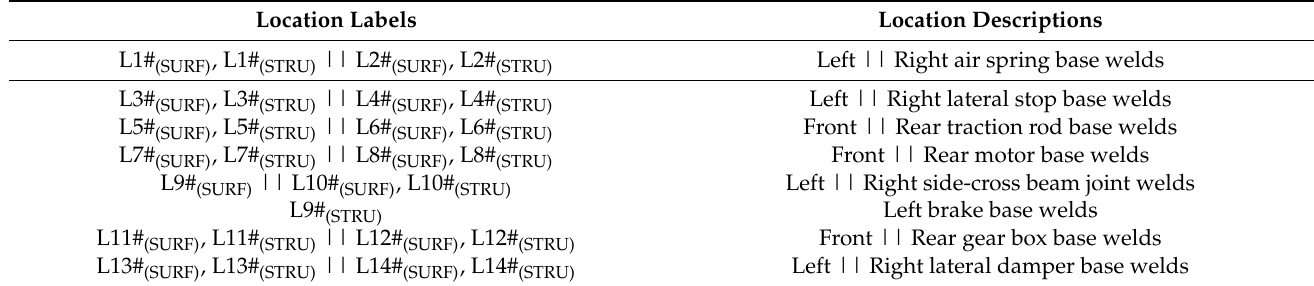
Table 4. Capture and assessment locations.